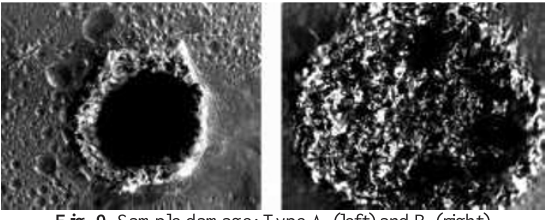
Fig. 9. Sample damage: Type A (left) and B